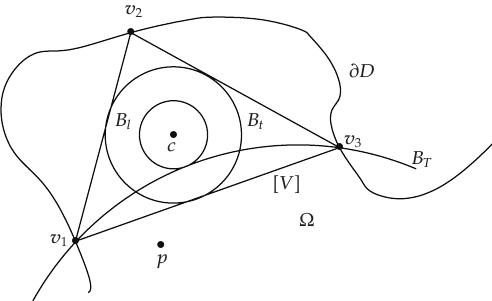
Figure 1: The largest ball B T tangent to B l and contained in Ω (cid:7) R n \ V , where V (cid:7) { v 1 ,v 2 ,v 3 }